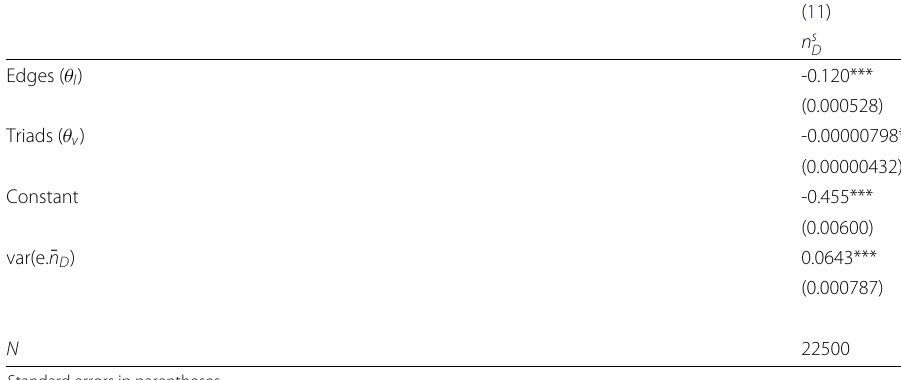
(11) n s D (0.000528)